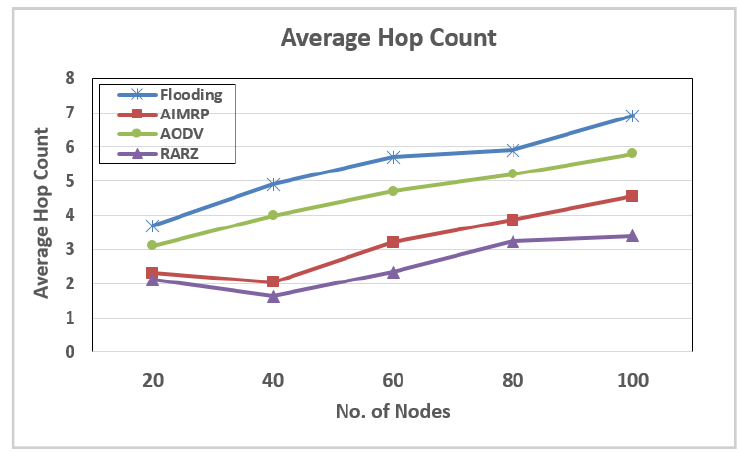
Figure 11. Average hop count vs. number of nodes.